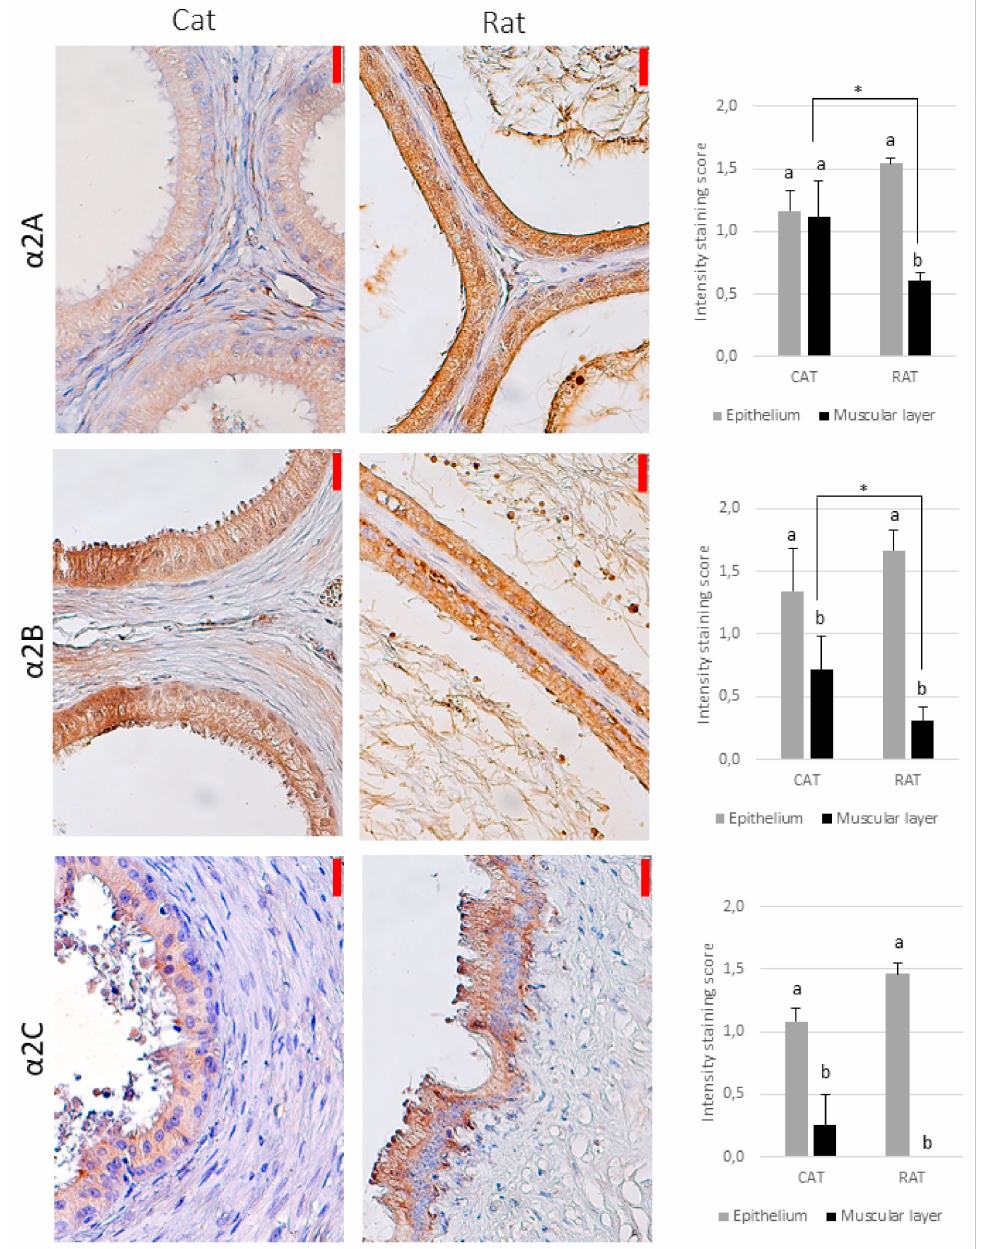
Figure 3. The immunohistochemical localization of the α 2-adrenoceptors in the feline and rat reproductive tract − representative pictures of the epididymis (counterstained with hematoxylin, magnification 400 × ). The red bar on the upper right of each image represents 20 µ m. The graphs on the right present the average reaction intensity score ( n = 6). Because of the lack of difference between the regions for most of the receptors investigated, the data are shown as the average intensity of staining for the regions analyzed and SEM, for the sake of clarity. The different letters above the bars (a, b) indicate significant ( p < 0.05) differences between the epithelium and muscular layer within a species. An asterisk (*) indicates a significant difference between the